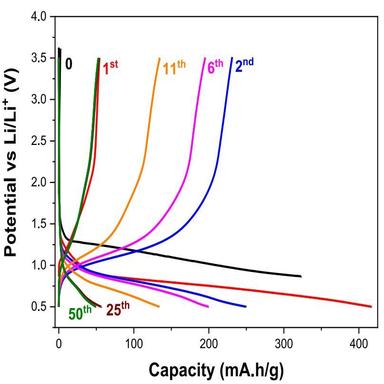
Electrochemical performance of Ni3(C8H4O4)3(C3H7NO)4: galvanostatic discharge−charge profiles.